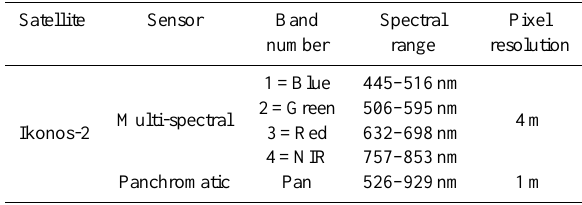
Table 1. Ikonos satellite sensor